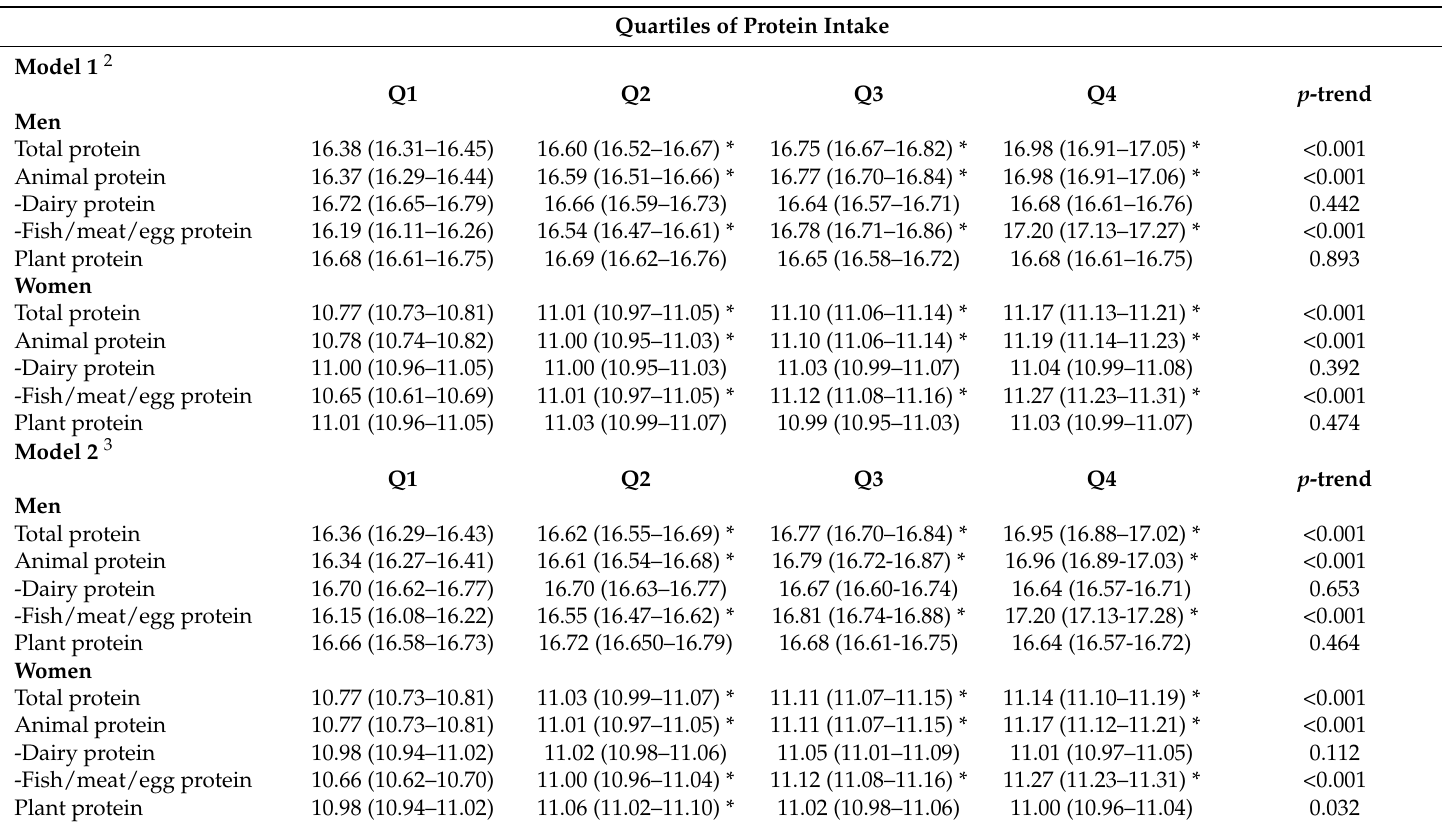
Table 2. Adjusted least square means for creatinine excretion (mmoL/24 h) among the different quartiles of energy-adjusted protein intake 1